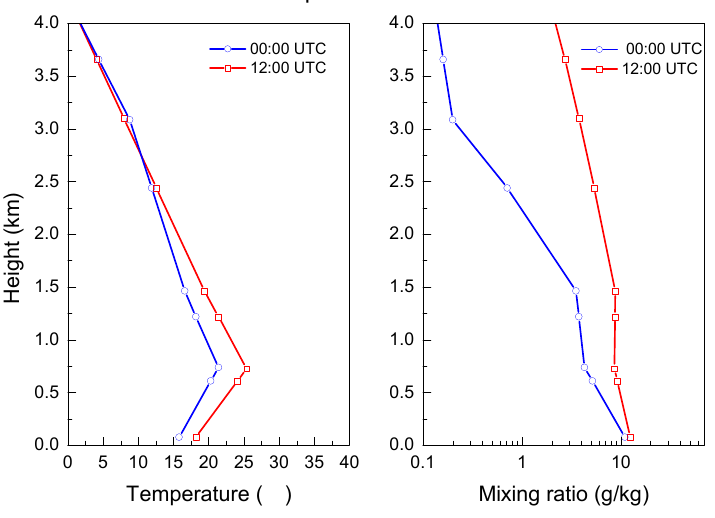
Figure 12. The temperature and water vapor mixing ratio profiles from the radiosonde on 3 June